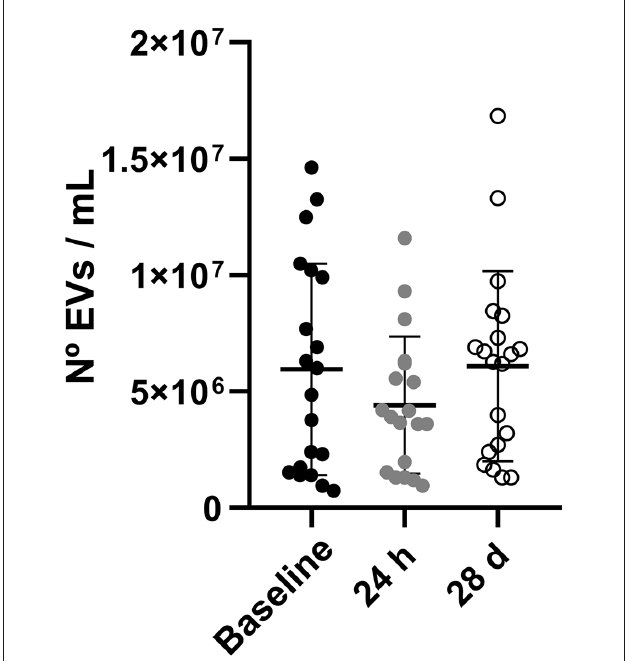
FIGURE3 Number of blood-derived EVs at baseline, 24 h and 28 days. Data are shown as mean ± SD. Abbreviations: EVs, extracellular vesicles.